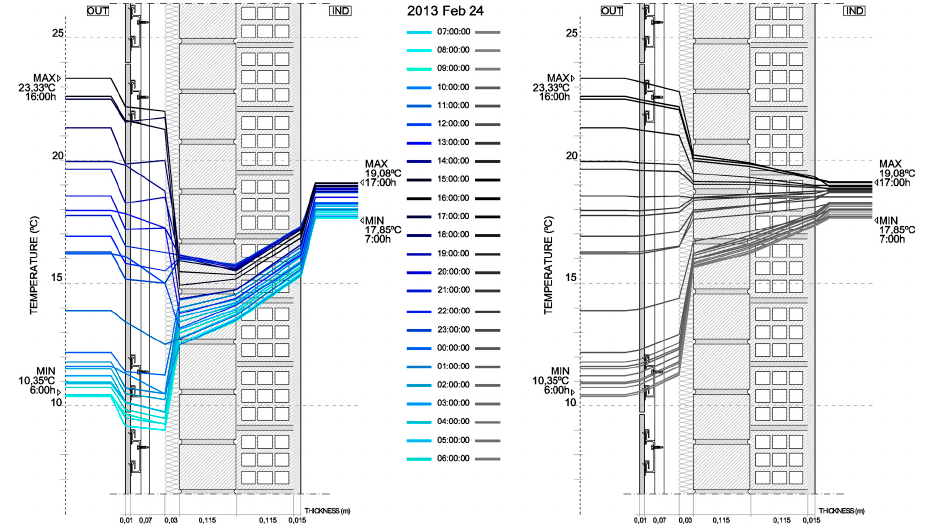
Figure 13. Dynamic temperature graphs showing each hour on 29 July 2013. ( Left ) Data obtained by monitoring; ( Right ) gradients in steady state according to Fourier.